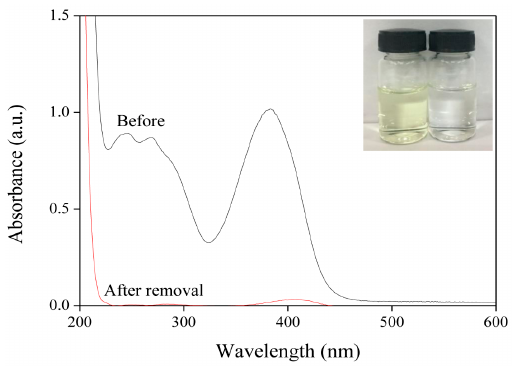
Figure 1. UV - vis absorption spectra of TC in aqueous solution at an initial concentration of 30 mg L − 1 ; before and after removal for 4 min contact time, with corresponding photograph images of the solution ( inset ).